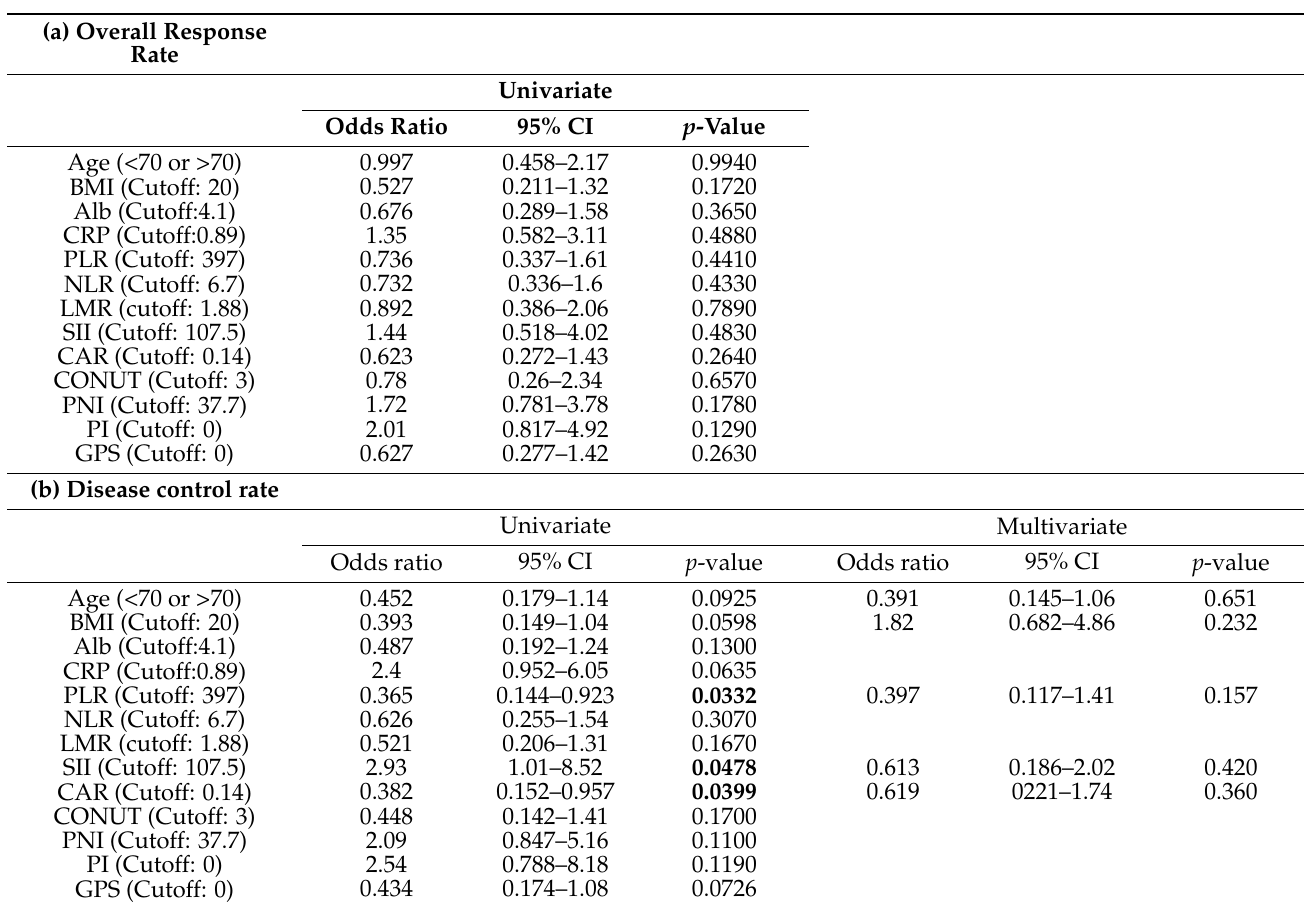
Table 3. Prognostic analysis of ORR (a) and DCR (b) in patients who received immune checkpoint inhibitor therapy.